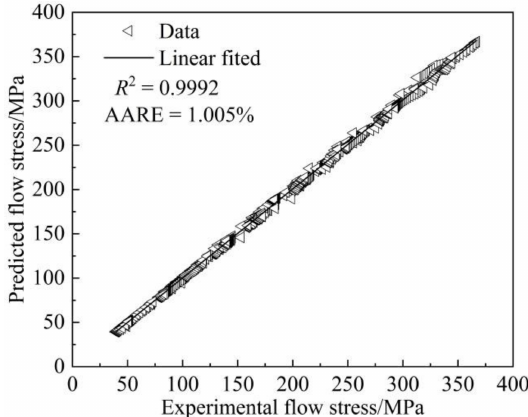
Figure 6. Correlation between predicted and experimental flow stress